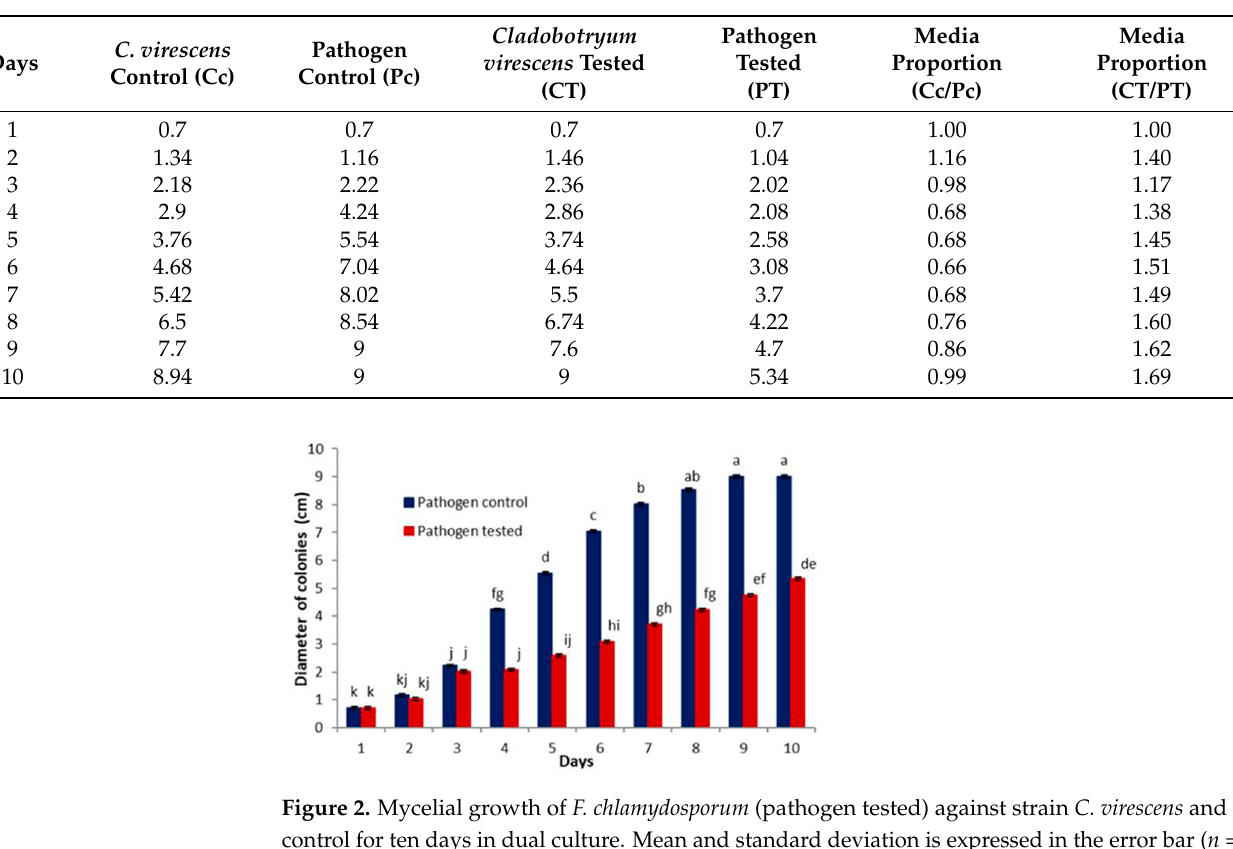
Table 4. Competition for nutrients. In vitro inhibition activity of C. virescens on mycelial growth (cm) of F. chlamydosporum from day 1 to 10 on OA medium. Media proportion was calculated as: mycelial growth diameter of C. virescens / F. chlamydosporum CT and Cc refer to tested and control C. virescens , respectively. Pc and PT refer to tested and control pathogen F. chlamydosporum, respectively.